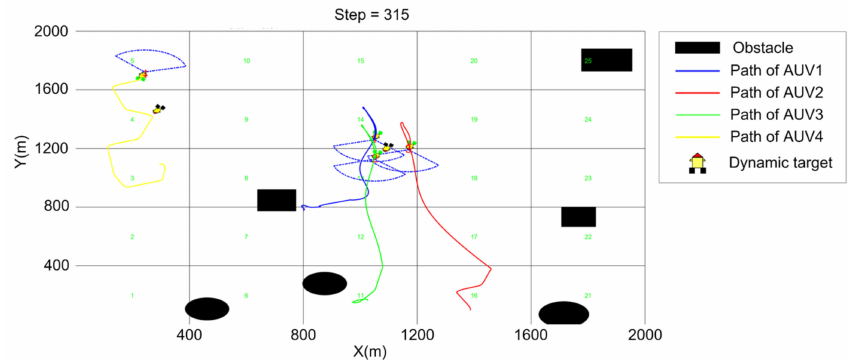
Figure 18. T = 315 (steps).